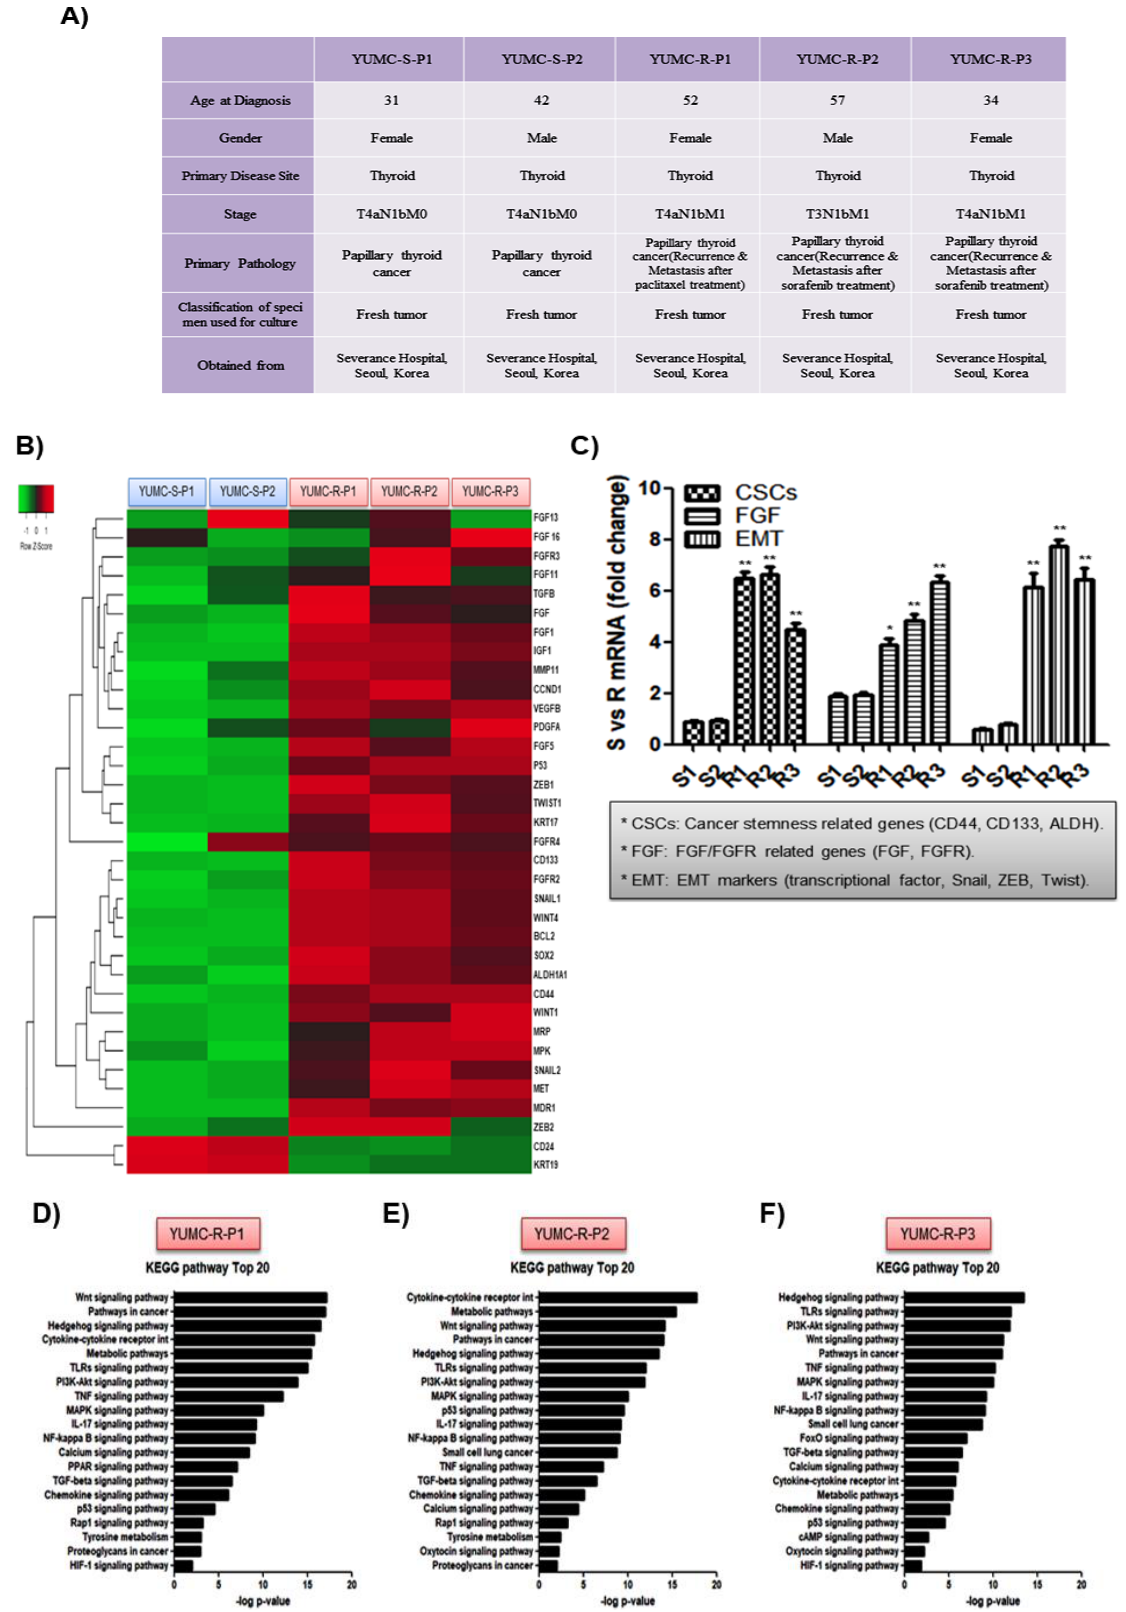
Figure 2. Characteristics of all examined papillary thyroid cancer (PTC) cell lines. ( A ) Characteristics of patient-derived subtypes of PTC cell lines, ( B ) hierarchical clustering of annotated genes